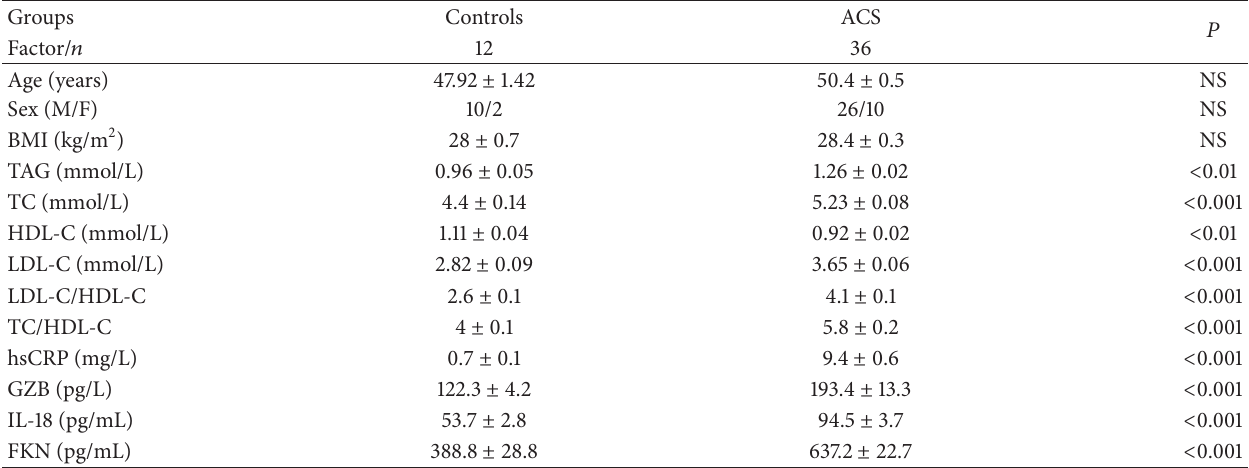
Table 1: Demographic data and clinicopathological parameters of the studied